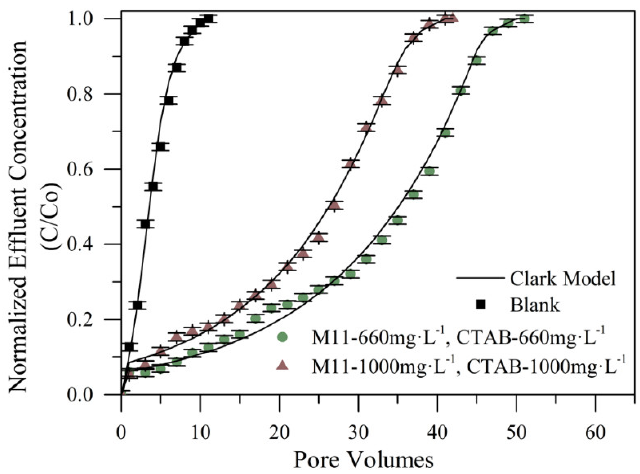
Figure 11. Breakthrough curves for different concentrations of MgO nanoparticles (M11)/CTAB of the system I in Ottawa 20/40 sand packed bed assessed with a kaolinite 0.2% in the mass fraction solution at 25 °C.